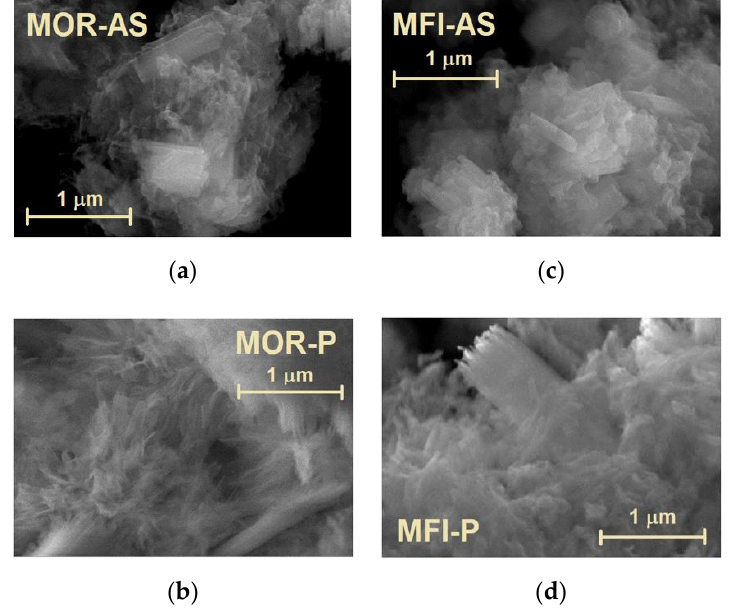
Figure 3. SEM images of the samples, as synthetized and pillared: MOR-AS ( a ), MOR-P ( b ), MFI-AS ( c ), MFI-P ( d ).